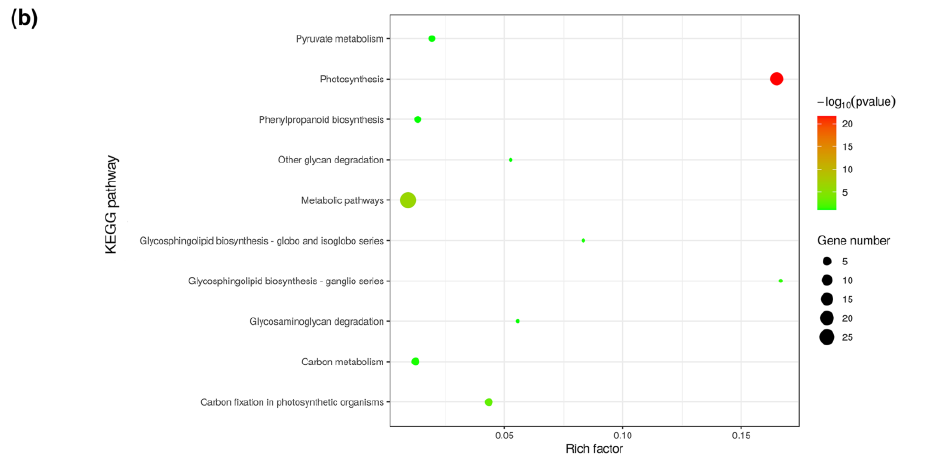
Figure 7. Gene ontology (GO) classification and Kyoto Encyclopedia of Genes and Genomes (KEGG) enrichment of differentially expressed peptides (DEPs) in maize. ( a ) The results are summarized in three main categories: biological process; cellular component; and molecular function. The x -axis indicates the number and percent of genes in a category. The y -axis indicates the most enriched GO terms in three main categories. Max level indicates maximal annotated level of this term in the GO graph. ( b ) Distribution of enriched KEGG pathway analysis of the 147 precursor proteins of common DEPs. The x -axis indicates rich factor and the y -axis indicates pathway.